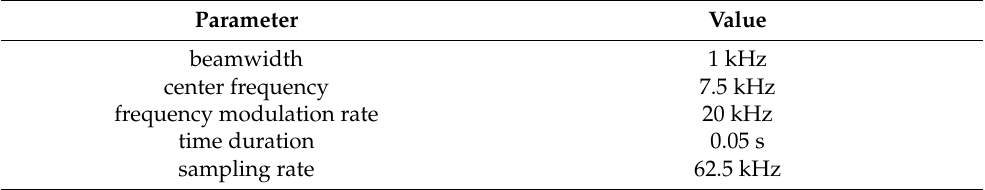
Table 1. Parameters of LFM signal.